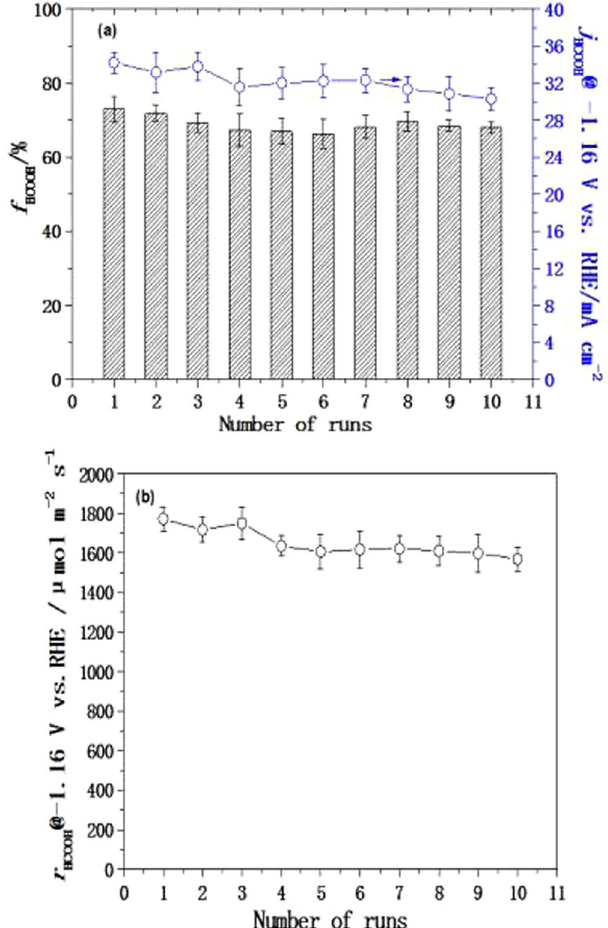
Figure 8. The f HCOOH , j HCOOH and r HCOOH as functions of the number of runs for ERCF at − 1.16 V vs. RHE in 0.5 M